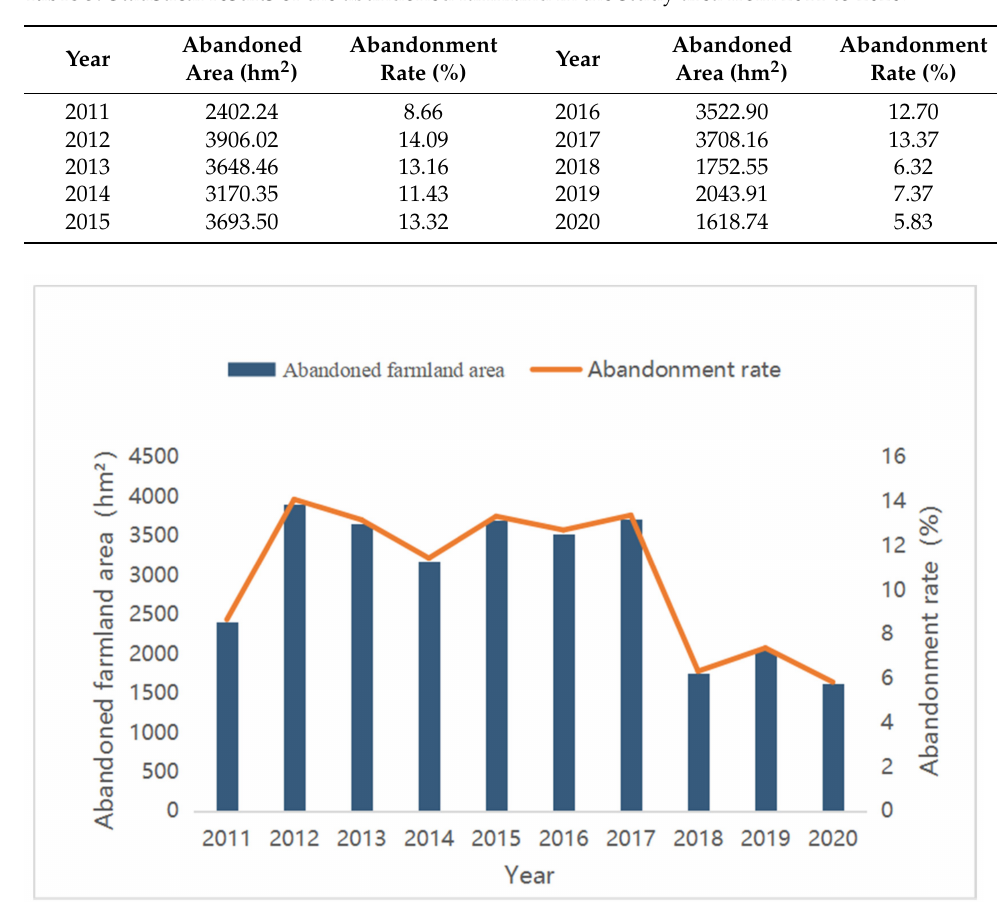
Figure 7. Abandoned farmland area and abandonment rate in Luquan for the period